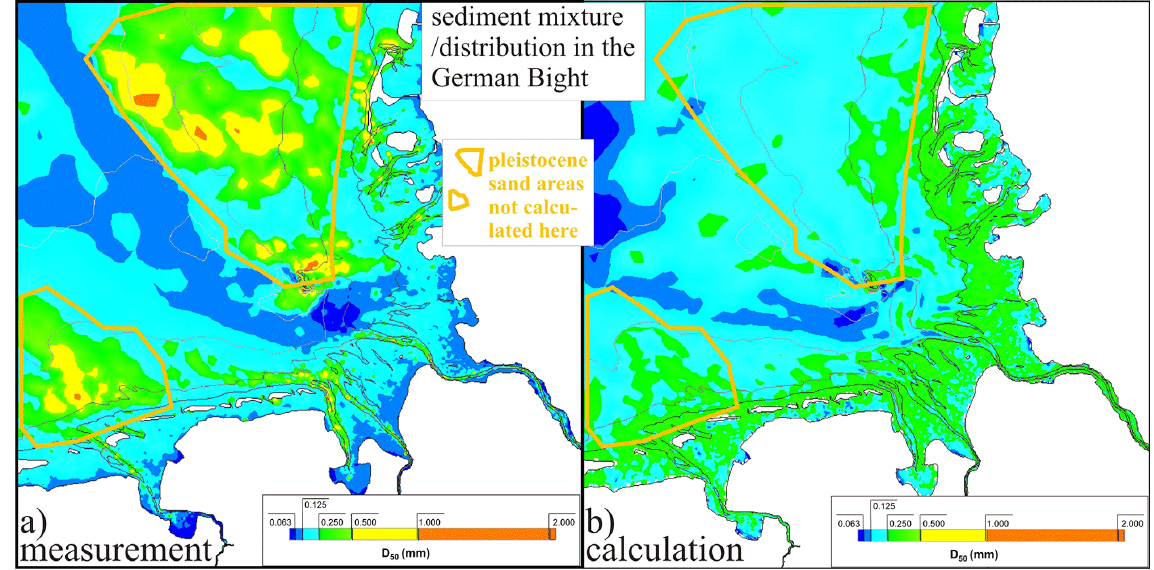
Fig. 1. Initial sediment mixture/distribution in the German Bight from (a) measurements and (b) numerical model calculation